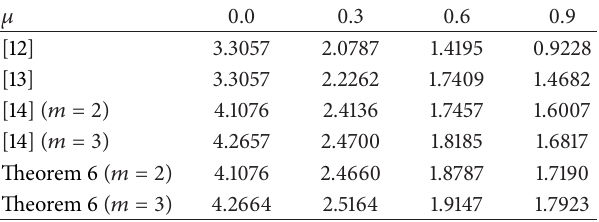
Table 1: Maximum allowable time-delay bounds ℎ for different 𝜇